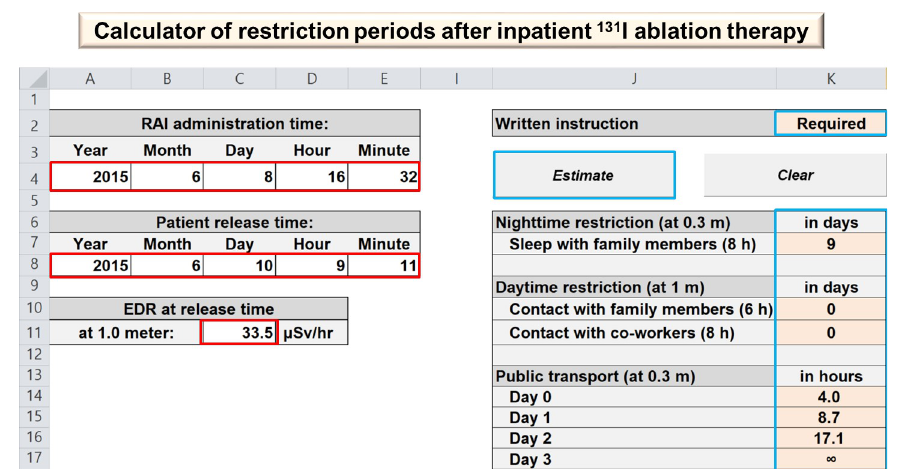
Fig 4. An example of spreadsheet for calculation of restriction periods after inpatient 131 I ablation therapy (S1 File): Data input screen (marked in red) and generated restriction periods after “Estimate” button (marked in